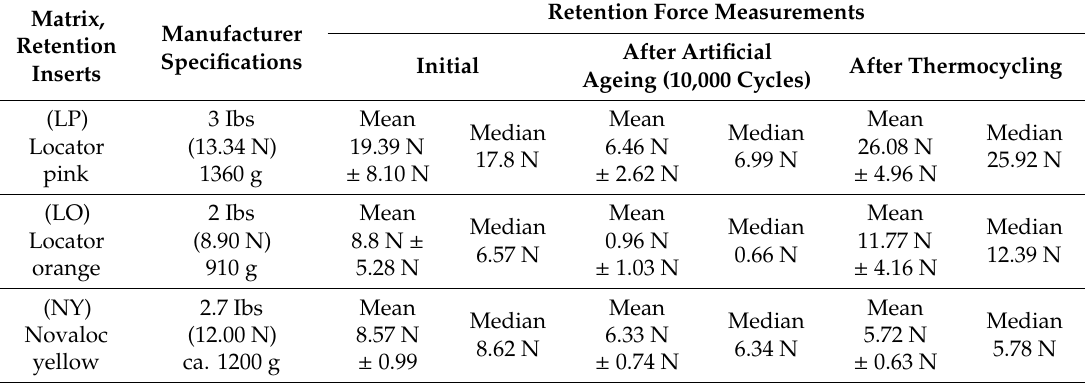
Table 2. Mean values and standard deviation of retention force measurements with respect to the matrix color